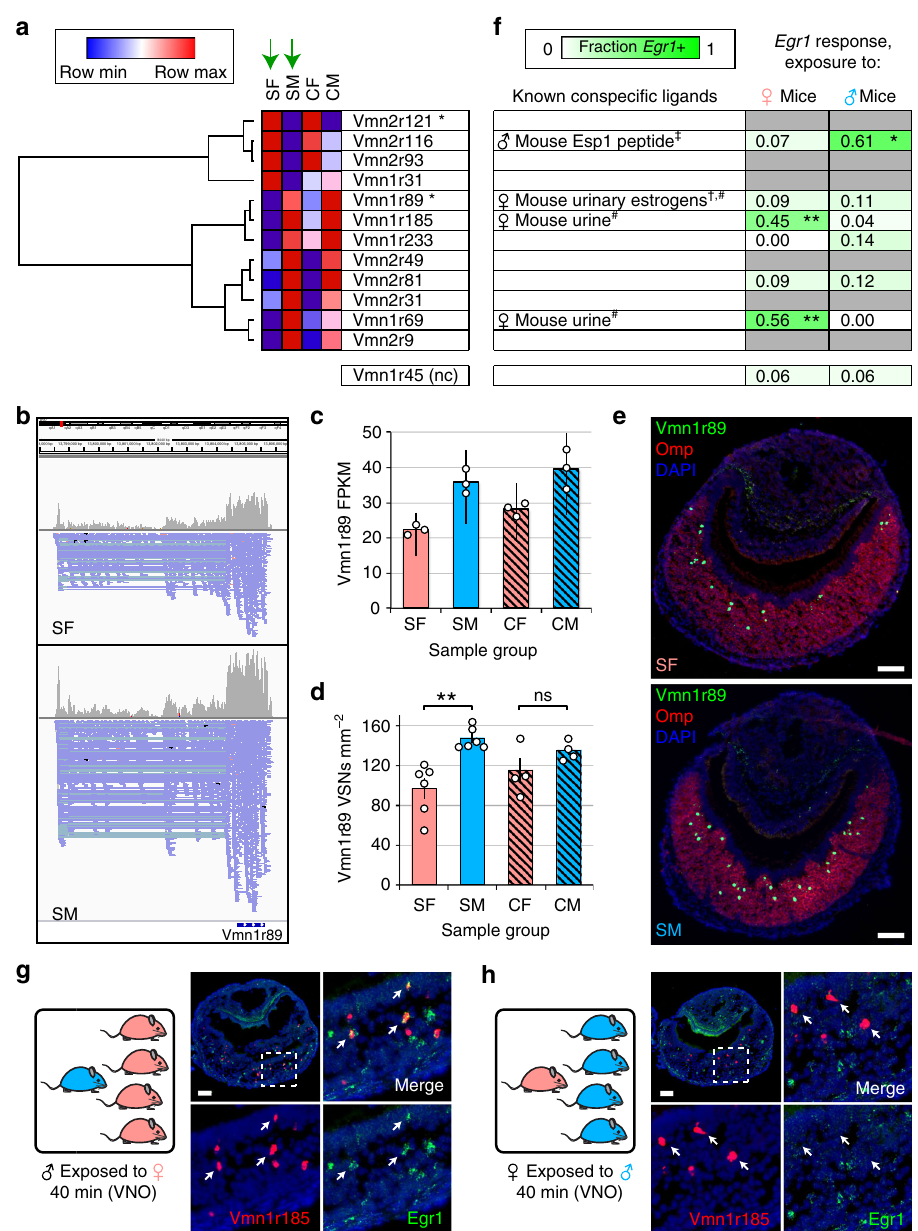
Fig. 5 VRs with sex-speci fi c expression differences exhibit sex-speci fi c expression frequencies and detect sex-speci fi c odors. a Hierarchical clustering of VRs identi fi ed via RNA-seq as differentially expressed between SF and SM mice (green arrows). VRs labeled asterisk, FDR < 0.05; other VRs shown, unadjusted p < 0.01 (Cuf fl inks output). b RNA-seq read alignments to Vmn1r89 for SF and SM samples. Alignments from the three biological replicates in each experimental group were combined (SF, top; SM; bottom). Strand orientation: − , pink; + , blue. c VNO expression levels, based on RNA-seq, for Vmn1r89 . Error bars: 95% c.i. d Quanti fi cation, using two-color RNA-FISH, of the frequency of Vmn1r89 -expressing VSNs relative to all mature VSNs (based on Omp expression). Error bars: s.e.m. ** p < 0.01 (two-tailed t test); n = 4 – 6 mice (5 sections/mouse; average of 17 Vmn1r89 -expressing VSNs/section). Dots represent average values for individual mice. e Representative images of Vmn1r89 expression in the VNO of the experimental mouse groups shown. f (Left) Known conspeci fi c activators of the VRs shown in a , based on † : ref. 39 , ‡ : ref. 35 , #: ref. 38 . (Right) Quanti fi cation, based on two-color RNA-FISH, of the fraction of VSNs that co-express the VRs listed in a and Egr1 within the VNOs of individual male mice exposed to 4 females ( ♀ mice) or females exposed to 4 males ( ♂ mice) for 40 min. Vmn1r45 is a representative negative control VR. Statistical results in f are based on comparisons between the fractions of VSNs co-expressing Egr1 after exposure to female or male mice. * p < 0.05, ** p < 0.01 (two-tailed t test); n = 4 VNO sections (average of eight speci fi c VR-expressing VSNs/section); gray fi ll: not tested. g , h Representative images of two-color RNA-FISH analyses of Vmn1r185 co-expression with Egr1 following exposure of a male mouse to four females ( ♂ exposed to ♀ ; g) or a female mouse to four males ( ♀ exposed to ♂ ; h). Arrows: locations of representative Vmn1r185 -expressing cells. SF sex-separated females, SM sex-separated males, CF sex-combined females, SM sex-combined males. Scale bars: 100 µ